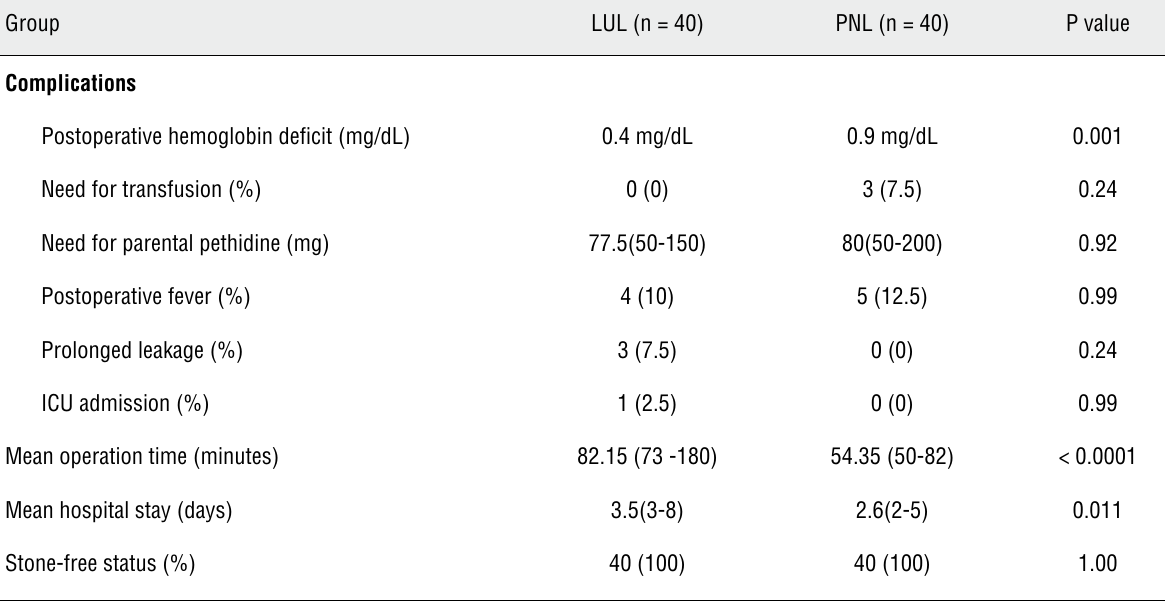
Table 2 - Patients’ Intraoperative and postoperative data.